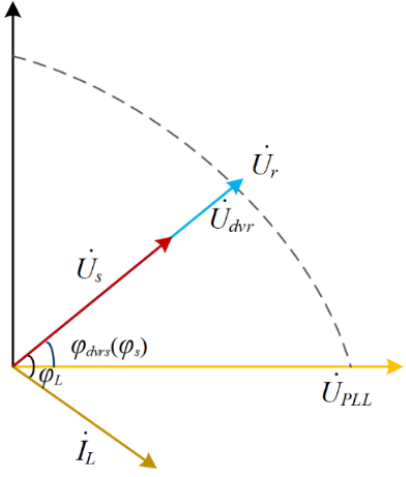
Figure 2. In-phase compensation phasor diagram.